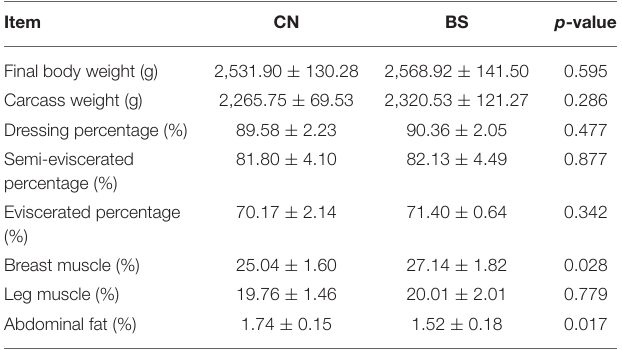
TABLE 2 | Effects of Bacillus subtilis supplementation on carcass traits of broiler chickens.